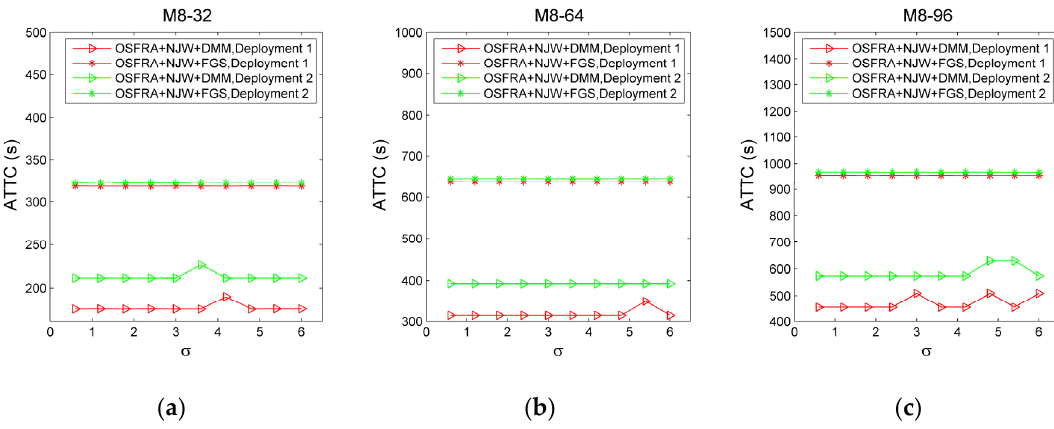
Figure 11. The average total time consumption (ATTC) comparison for OSFRA+NJW+DMM and OSFRA+NJW+FGS under various σ , mapping instances and tracking tag deployments. ( a ) M8-32. ( b ) M8-64. ( c ) M8-96.